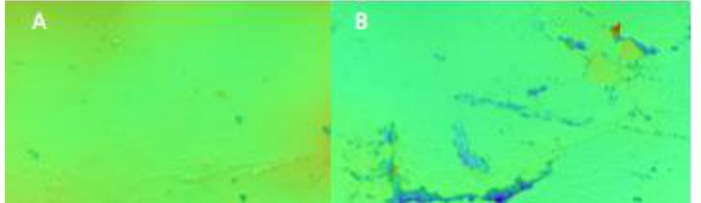
Figure 4. 3D surface roughness profile of gluten obtained from wheat cultivated after sugar beet as a forecrop observed using optical profilometer. ( A ) — unsonicated; ( B ) — sonicated (surface = 0.9 × 1.3 mm).